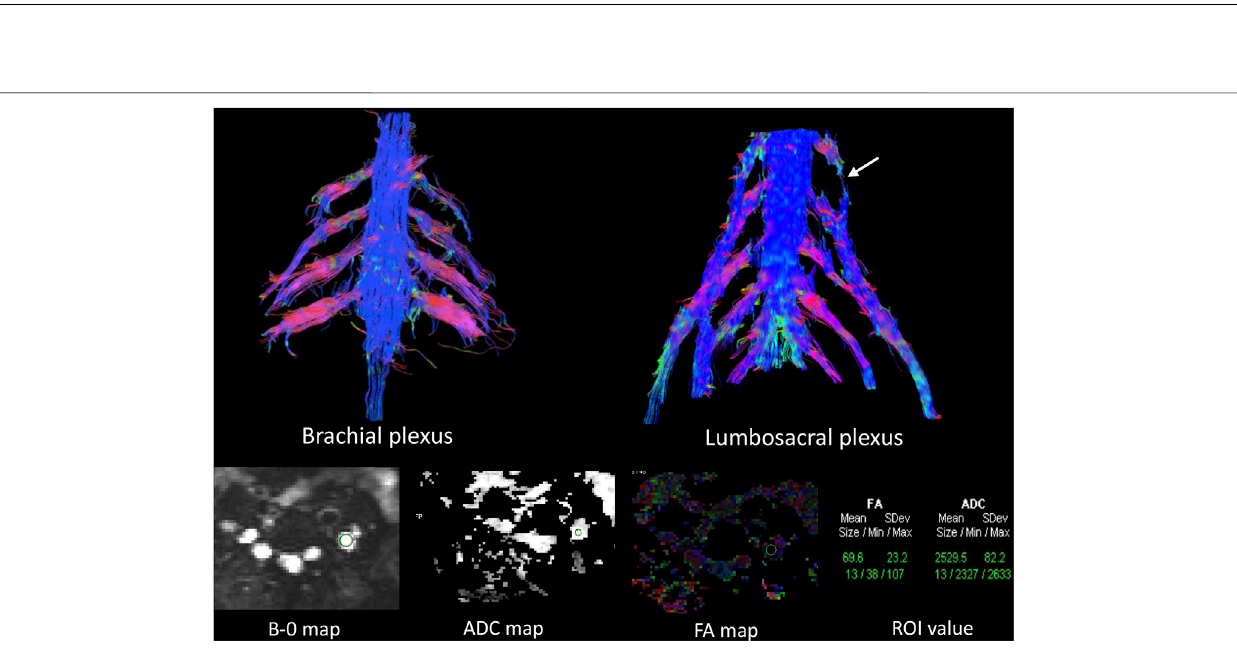
FIGURE4| Diffusiontensortractography (DTT)revealedsigni fi cantlythickened and distorteddiscontinuoustractsinthebrachialandlumbosacral(LS)plexus. The FA value was signi fi cantly decreased, while the ADC value was increased in the plexus. The left L4 nerve roots were almost interrupted in DTT (arrows in the LS plexus), corresponding to fusiform hypertrophy, the site in which the FA (0.069) and ADC values (2.529) were close to the diffusion weighting of the free water.